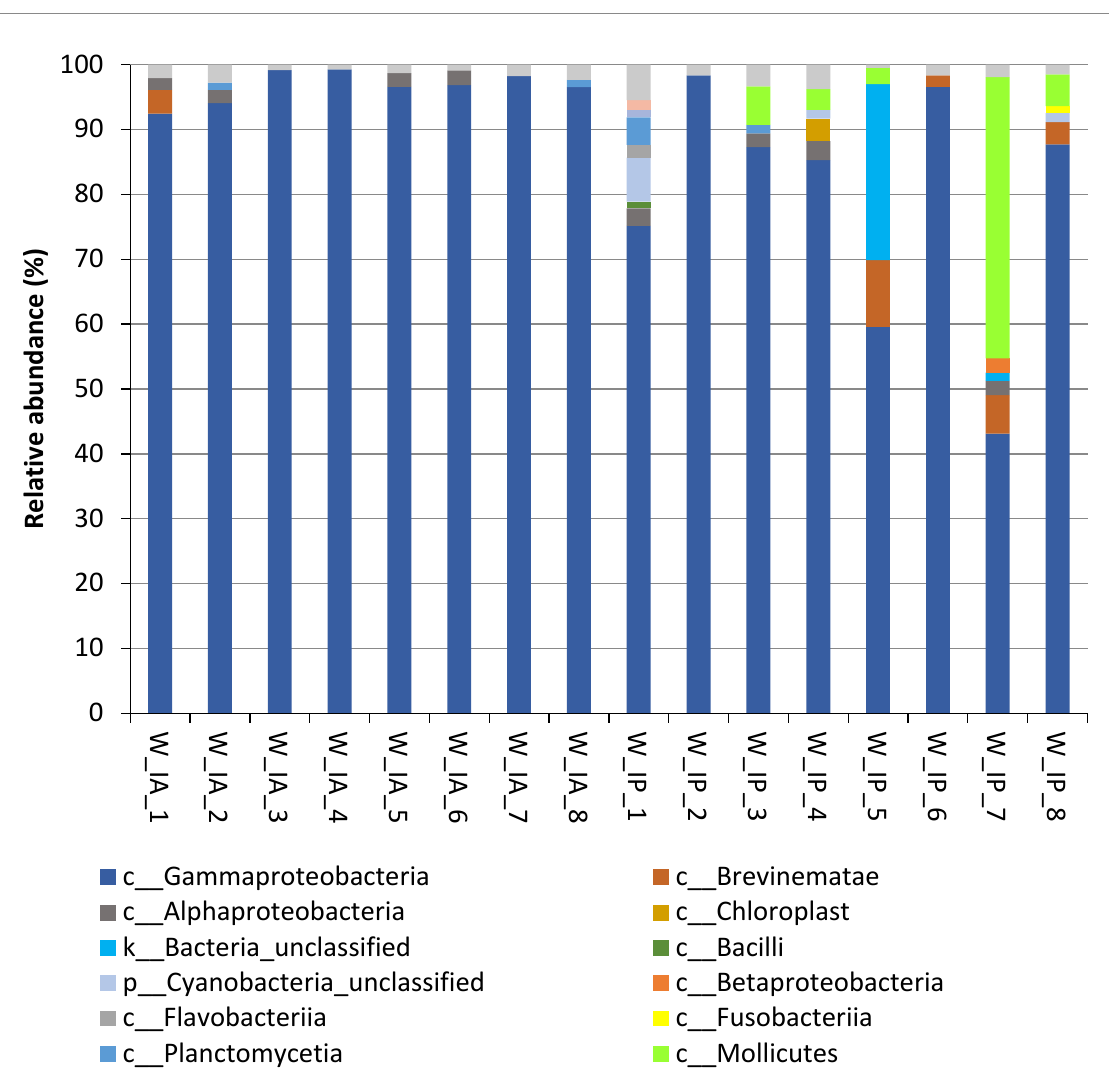
Figure 3. Relative abundance (percentage) at class level for each sample of intestinal microbiota from anterior and posterior sections of wild C. labrosus . In the figure, W_IA corresponds to the anterior intestinal section of wild fish, and W_IP corresponds to the posterior intestinal section of wild fish.